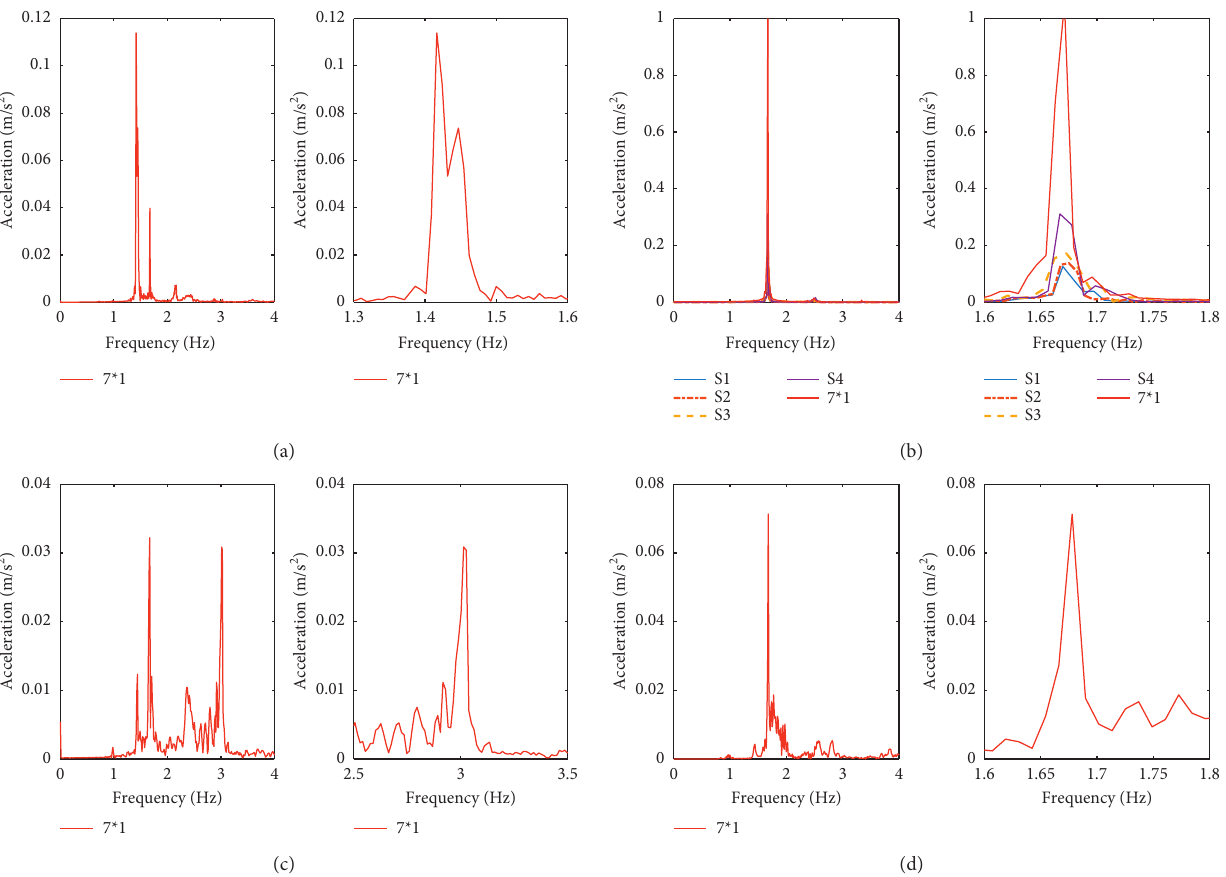
Figure 12: Frequency spectrum: (a) Group (7 × 1) walking at 1.44Hz; (b) single-person and multiperson (7 × 1) walking at 1.67Hz; (c) group (7 × 1) running at 3.0Hz; (d) group (7 × 1) random